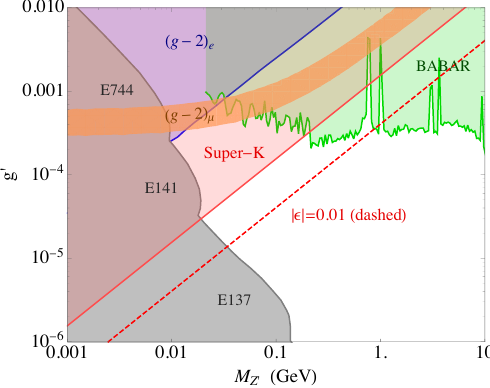
Figure 2 . Constraints on the parameter space of a lepton (cid:13)avorful short range force, which apply to gauge L e (cid:0) L (cid:22) model (similarly for the L e (cid:0) L (cid:28) model). The BaBar, electron and muon g (cid:0) 2 and beam dump (E744, E141, E137) experimental constraints are translated from those for the dark photon. The solid (dashed) curve corresponds to a neutrino matter potential (cid:15) (cid:22)(cid:22) = (cid:0) (cid:15) ee = (cid:0) 0 : 147 and (cid:0) 0 : 01, respectively. The red shaded region has been excluded by Super-K. This is another window where neutrino experiments stand at the frontier of probing such a new